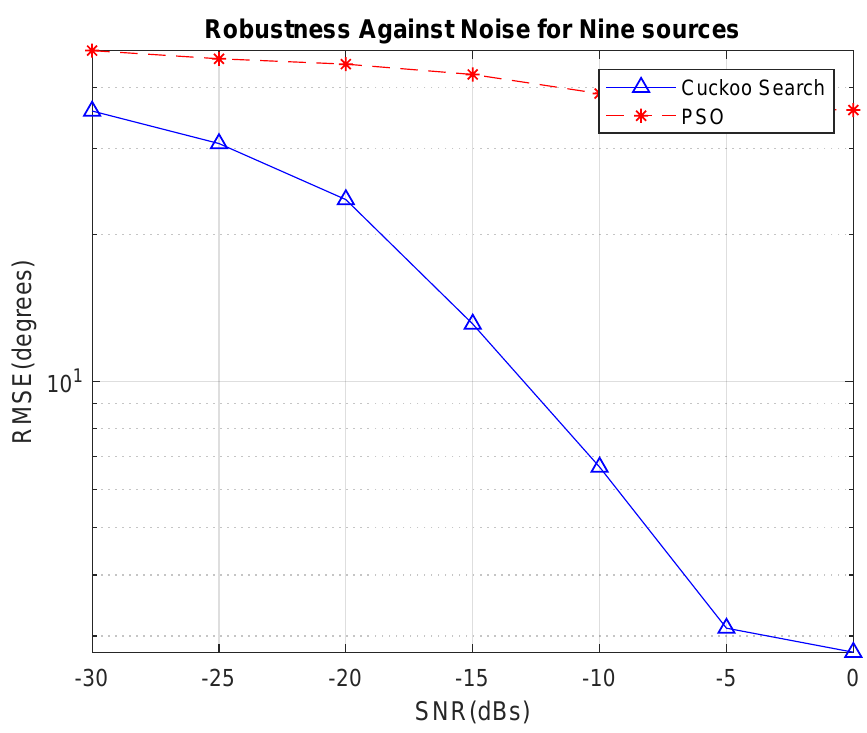
Figure 5. Robustness against noise for nine